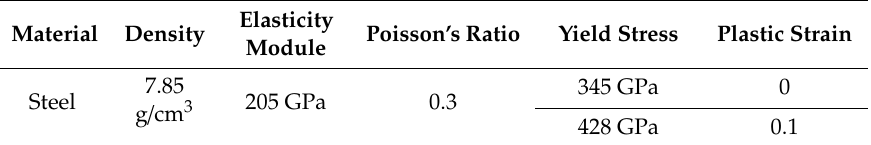
Figure 12. Internal view of FE model of towers I, II, III, IV. ( a ) Tower I, ( b ) Tower II, ( c ) Tower III, ( d ) Tower IV. Table 1. The material properties of steel.